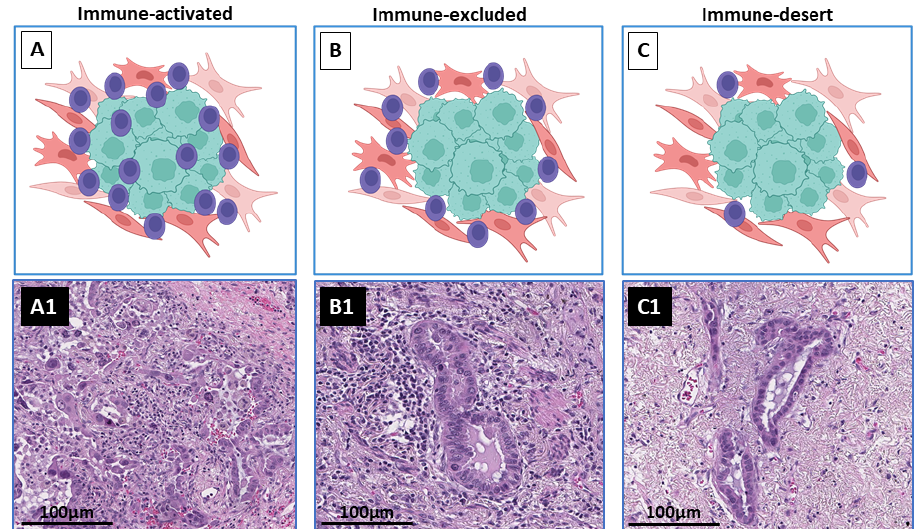
Figure 3. Tumor-immune responsiveness profile. Schematic representation of tumor response to immune checkpoint inhibitors. ( A ) Immune-activated, characterized by high degree of tumor-inflammatory infiltrate; ( A1 ) Representative H&E image showing immune-activated tumor immune profile. ( B ) Immune-excluded, characterized by presence of inflammatory cells in the tumor nest margin with no compromise of the tumor cells; ( B1 ) Representative H&E image showing immune-excluded tumor immune profile. ( C ) Immune-desert, characterized by absence of inflammatory cells within tumor nest and tumor margin; ( C1 ) Representative H&E image showing immune-desert tumor immune profile. Graphic created in part using Biorender (http://biorender.com, access date 27 April 2022).